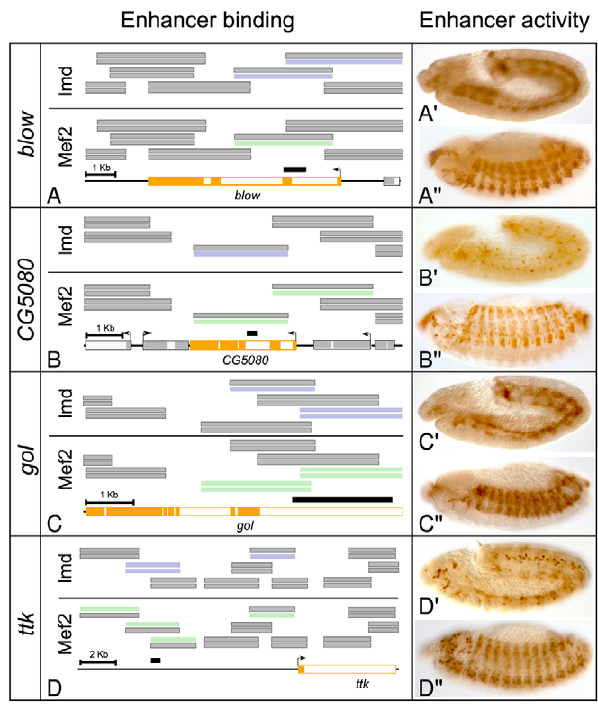
Figure 3. ChIP–bound regions function as enhancer elements capable of activating mesodermal expression in vivo . (A–D) Schematic overviews of the tiling array probes covering the (A) blow , (B) CG5080 , (C) gol and (D) ttk loci. Regions significantly enriched in Lmd ChIPs (blue) and Mef2 (green) were selected and intergenic sequences (black bars) assayed for regulatory activity in vivo . (A 9 –D 0 ) Immuno- histochemistry using an anti-GFP antibody to detect reporter gene expression. All four enriched sequences were able to specifically activate GFP expression in transgenic embryos in the mesoderm as early as (A 9 –D 9 ) stage 11, with persistent GFP-presence at (A 0 –D 0 ) stage 13.